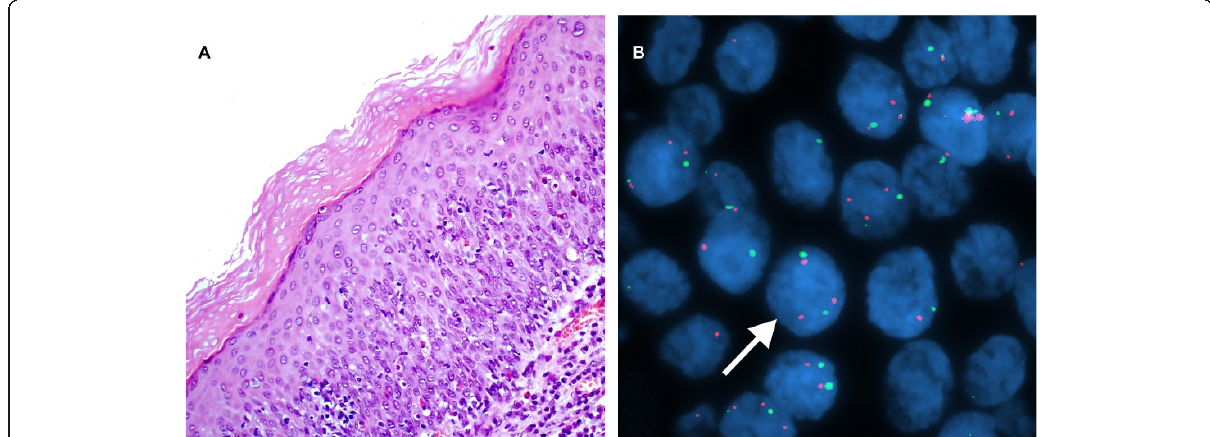
Figure 3 A case of moderate dysplasia of the larynx . A. H&E stain. (×200). B. Interphase FISH displaying a CSP3: hTERC signal pattern is 2:3 (green:red).